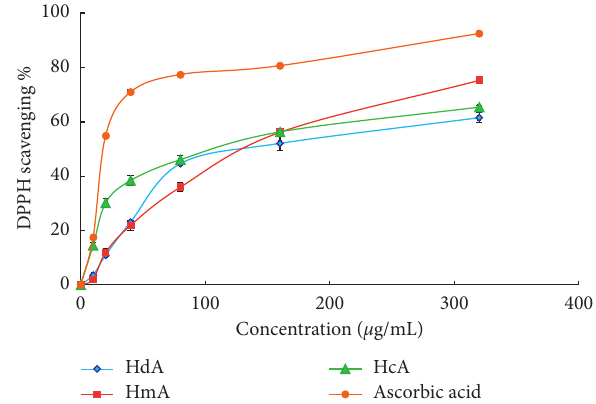
Figure 2: DPPH scavenging capacity of aqueous extracts of Hi- biscus deflersii (HdA), H. micranthus (HmA), and H. calyphyllus (HcA).